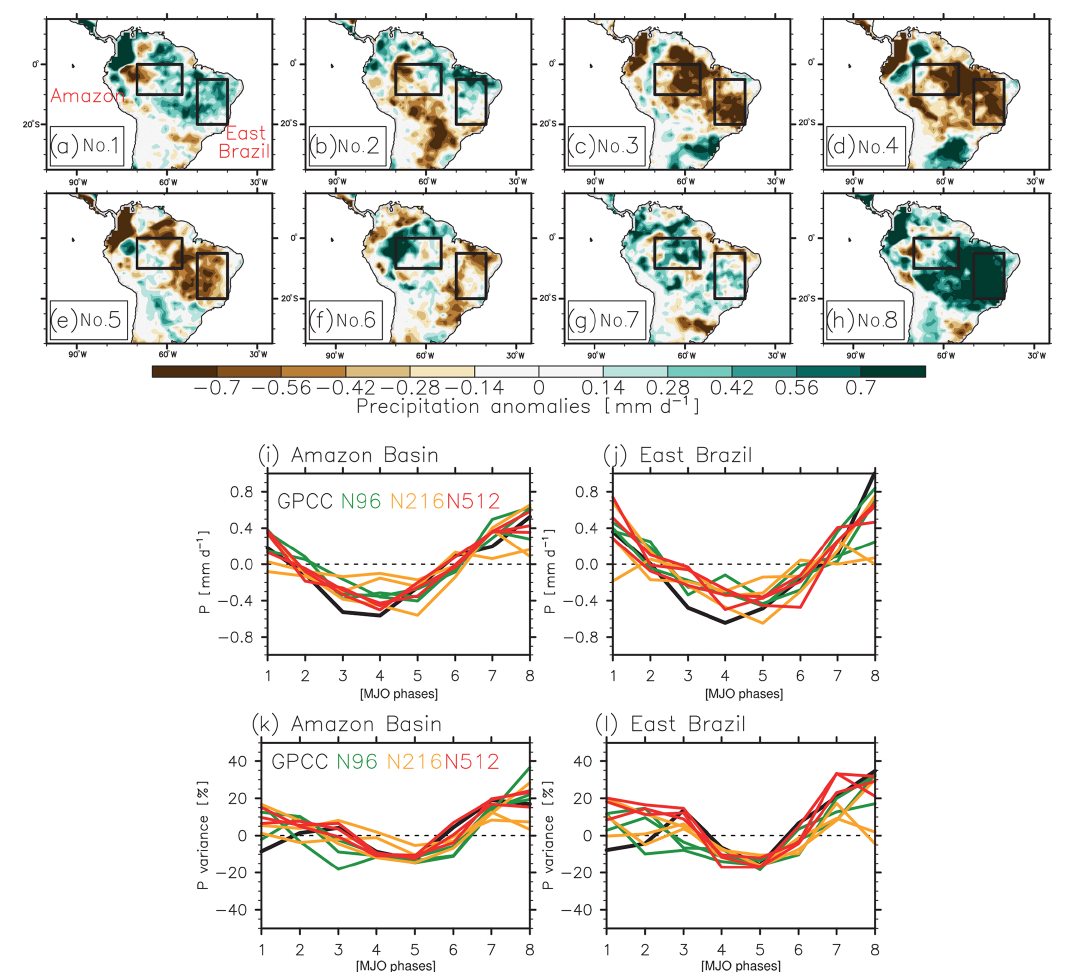
Figure 6. Observed impacts of Madden–Julian oscillation phase (a) 1, (b) 2, (c) 3, (d) 4, (e) 5, (f) 6, (g) 7, and (h) 8 on precipitation (GPCC and NCEP for the RMM index; mmd − 1 ). Precipitation anomalies (mmd − 1 ), associated with each phase of the Madden–Julian oscillation, relative to the period 1982–2014, and averaged over the (i) Amazon Basin and (j) East Brazil (see the box in a ), for observation (black), N96 (green), N216 (orange), and N512 (red). (k, l) As in (i) and (j) but for precipitation variance, in percent (%) of the precipitation variance over the period